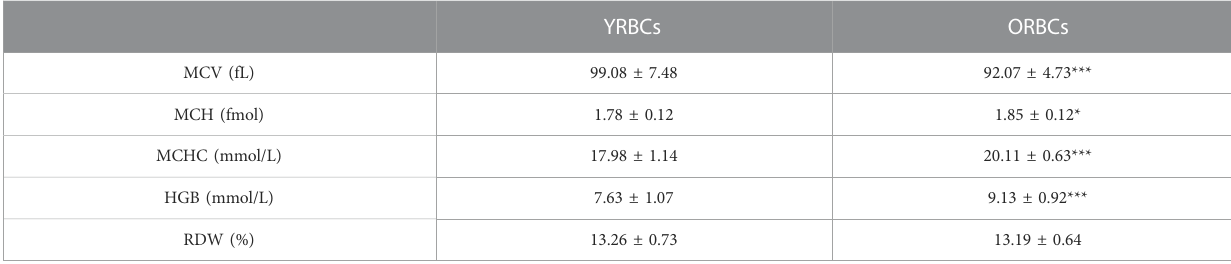
TABLE 1 Red blood cells quality parameters after Percoll